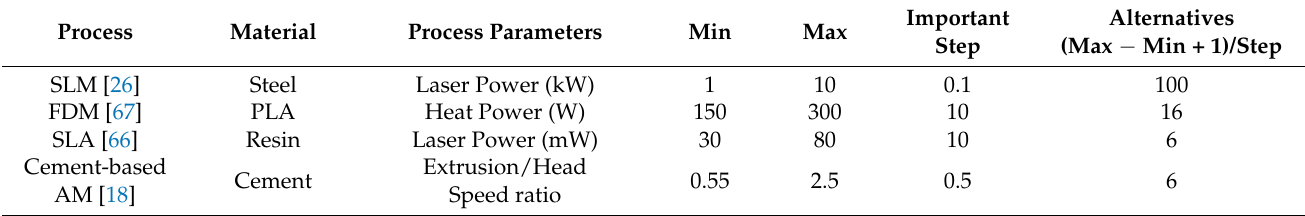
Table 2. Indicative quality-affecting process parameters per process, along with minimum, maximum, and important-step values and alternatives calculation.